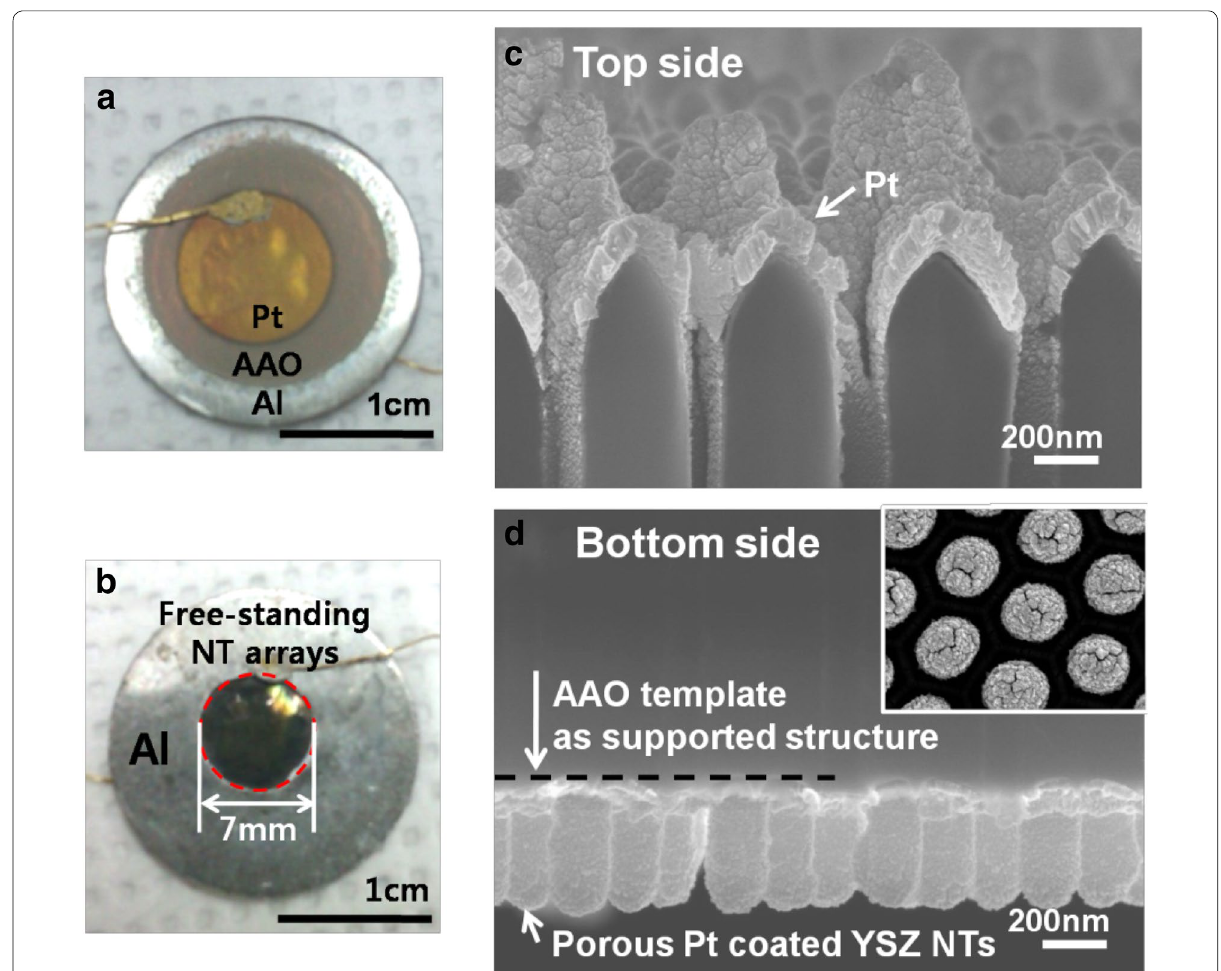
Fig. 6 a , b Photographs of free-standing YSZ-NT-based MEA with an active area of 7 mm in diameter. a Golden color shows porous Pt electrode on the YSZ NTs; gray color, YSZ NTs on AAO template; metal color, Al disk. b The corresponding back-side image, exposing the free-standing YSZ-NTs (dark green). c Cross-sectional SEM image of the top-side MEA, displaying porous Pt electrodes with ~ 80 nm thickness on the YSZ-NT membranes by sputtering. d SEM micrographs of porous Pt electrode coated on the exposed tubes in the partially etched alumina template. Inset, the plane